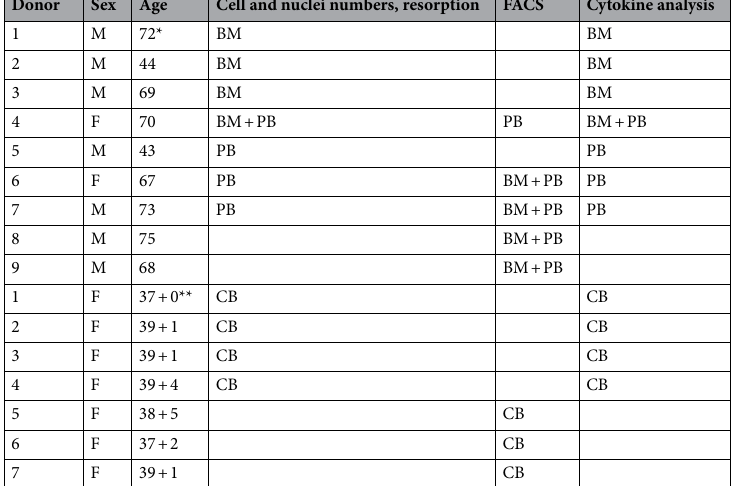
Table 1. Patient samples used in each experiment. *Years. **Gestational age at birth; weeks +